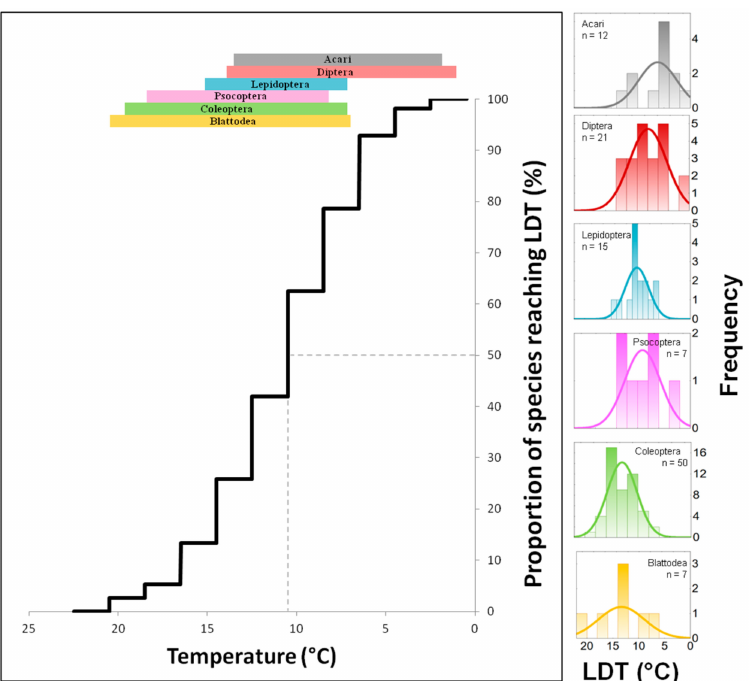
Figure 2. Exclusion function: Percentage proportion ( n = 112) of pest species (from Acari and 5 insect orders) that were excluded from development due to reaching a lower development threshold (LDT) at a particular decreasing temperature. Colour bands on the top of the figure show the particular temperature range of LDTs for each order. On the right-hand side of the figure, there are frequency histograms of LDTs for each